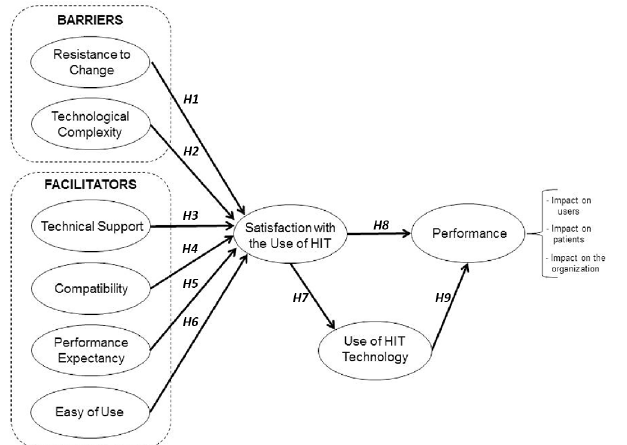
Figure 1. Conceptual